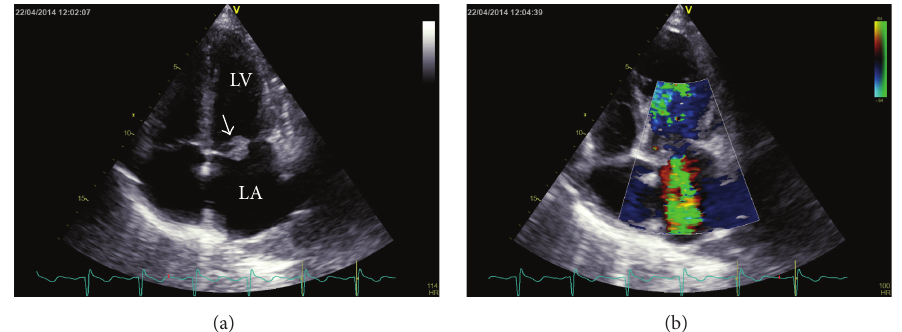
Figure 1: Transthoracic echocardiography (TTE), 4-chamber view of the heart. (a) The mitral valve is thickened and dysfunctional due to a floating vegetation (white arrow) on the anterior mitral leaflet; LA = left atrium; LV = left ventricle. (b) Color Doppler sonography shows severe mitral